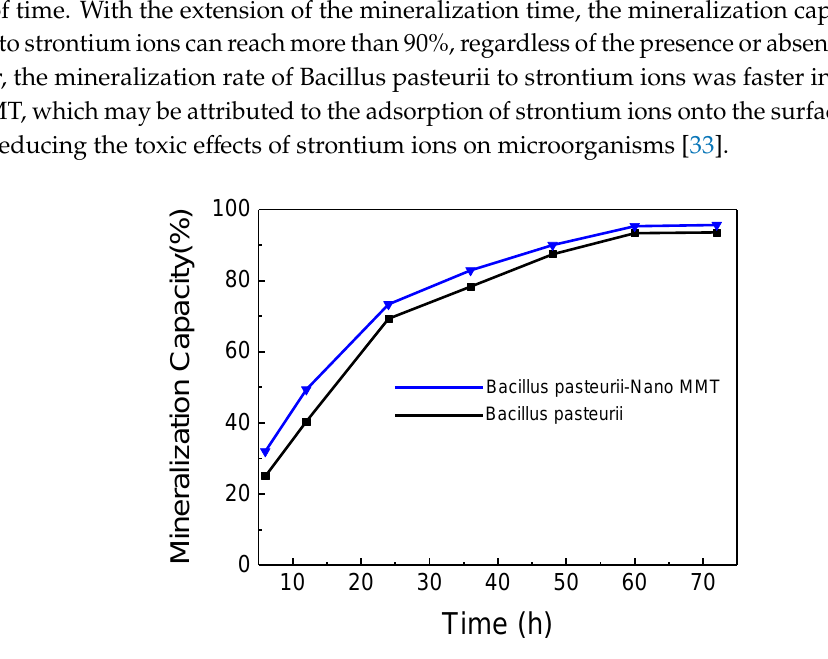
Figure 7. Mineralization efficiency of strontium ions in microbial mineralization systems. 4. Conclusions In summary, nano-MMT was used as a crystal growth regulator to prepare SrCO 3 with a complex flower-like superstructure in a microbial mineralization system. The effects of nano-MMT